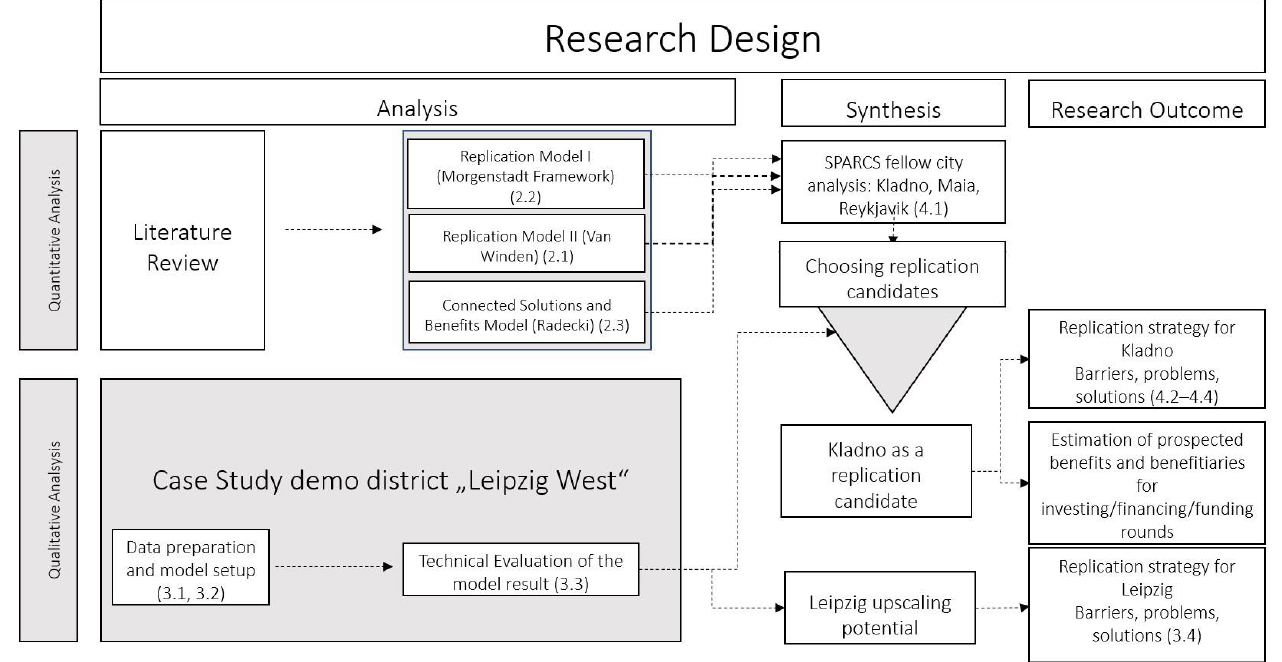
Figure 1. Research Design.